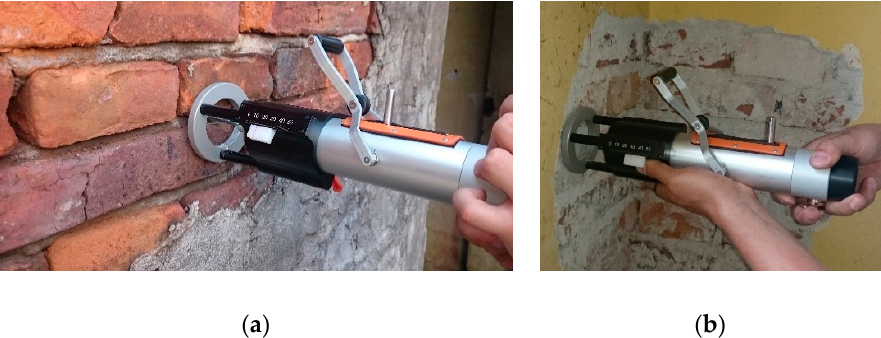
Figure 3. Penetrometer tests (PT)—the examples of test stands: ( a ) testing the mortar in the brick wall from the outside (non-plastered wall fragment); ( b ) testing the mortar in the masonry wall from the inside (after plaster